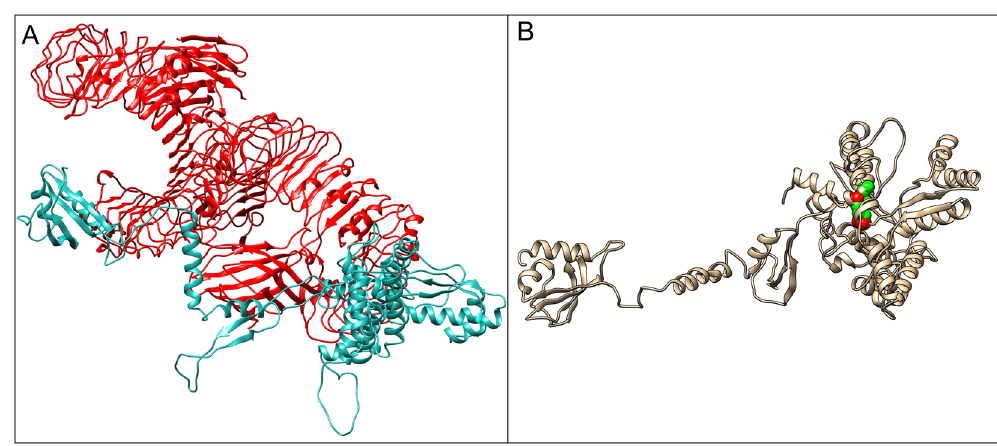
Figure 6. Docked complex of TLR-4 (PDB ID: 4G8A) with subunit vaccine construct. ( A ) Receptor (TLR-4) has been shown in red color whereas cyan color represents the multi-epitope vaccine as a ligand in the docked complex obtained from PatchDock server. ( B ) Representing disulfide bond engineered in the most flexible region with high